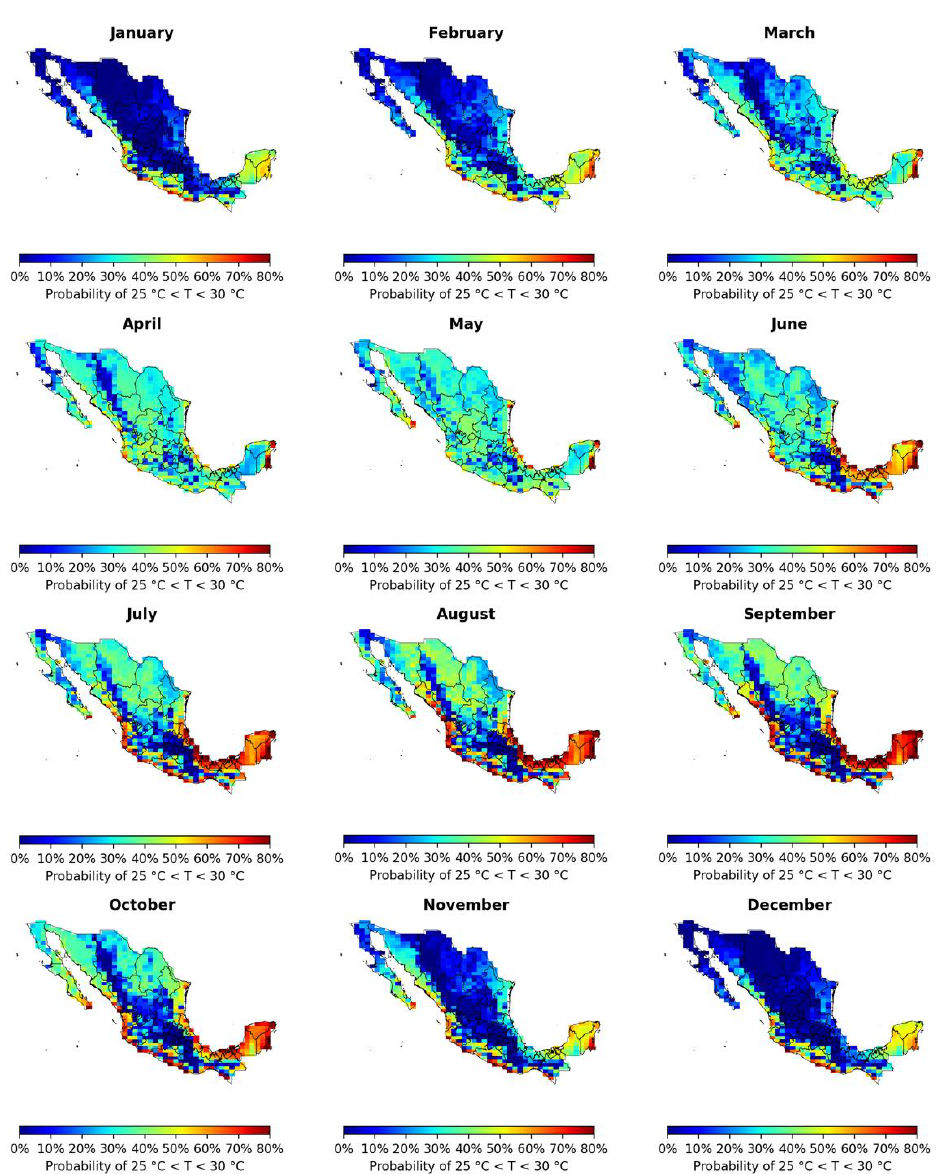
Figure 6. Probability map of ambient temperatures between 25⁡°C and 30⁡°C per month in Mexico.